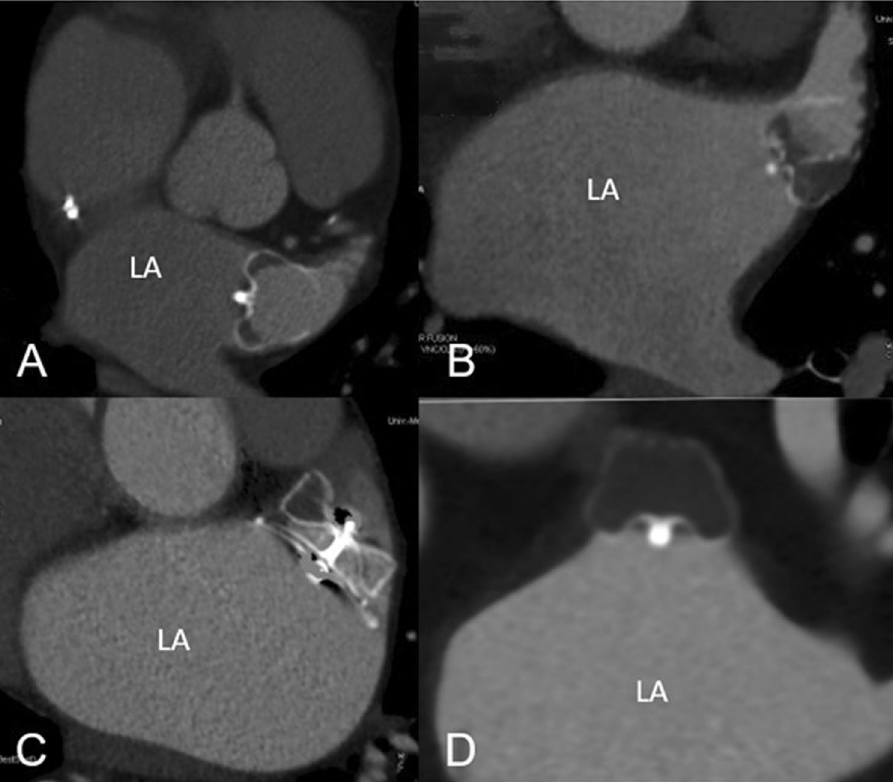
Figure 1. Illustrating different stages of LAA thrombosis using dual-energy cardiac CT. Panel A shows a hyperdense contrast agent flow in all parts of the LAA. Panel B shows a beginning thrombosis of the occlusion device with isodense flow, while in Panel C thrombosis has expanded to parts of the LAA with hypodense contrast agent flow in the remaining LAA. Panel D is an example of good device and LAA thrombosis with complete coverage of all lobes.